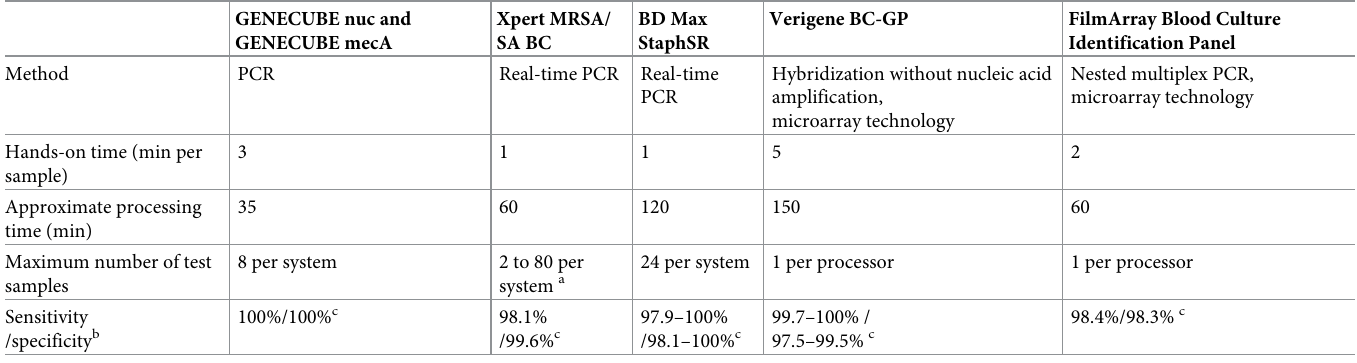
Table 1. Main characteristics of GENECUBE and other rapid molecular